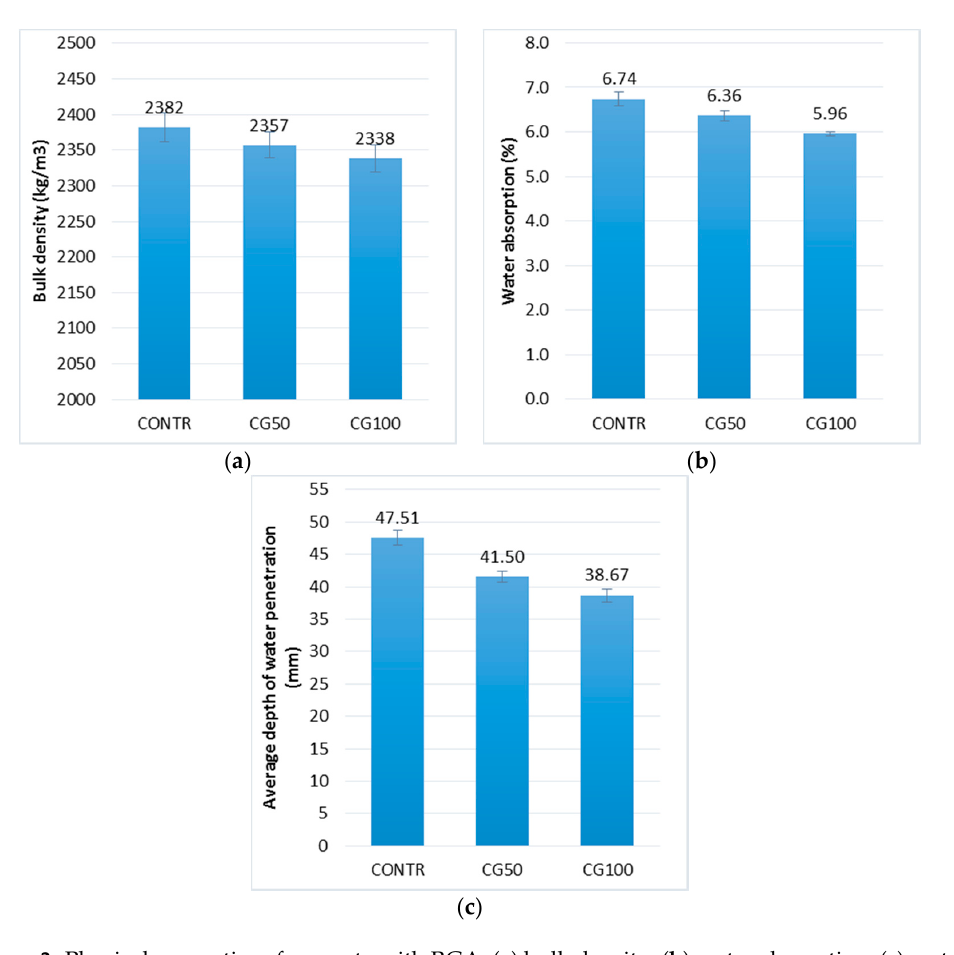
Figure 3. Physical properties of concrete with RGA: ( a ) bulk density; ( b ) water absorption; ( c ) water resistance (by means of average depth of water penetration); in the form of error bars, the standard deviation is shown.